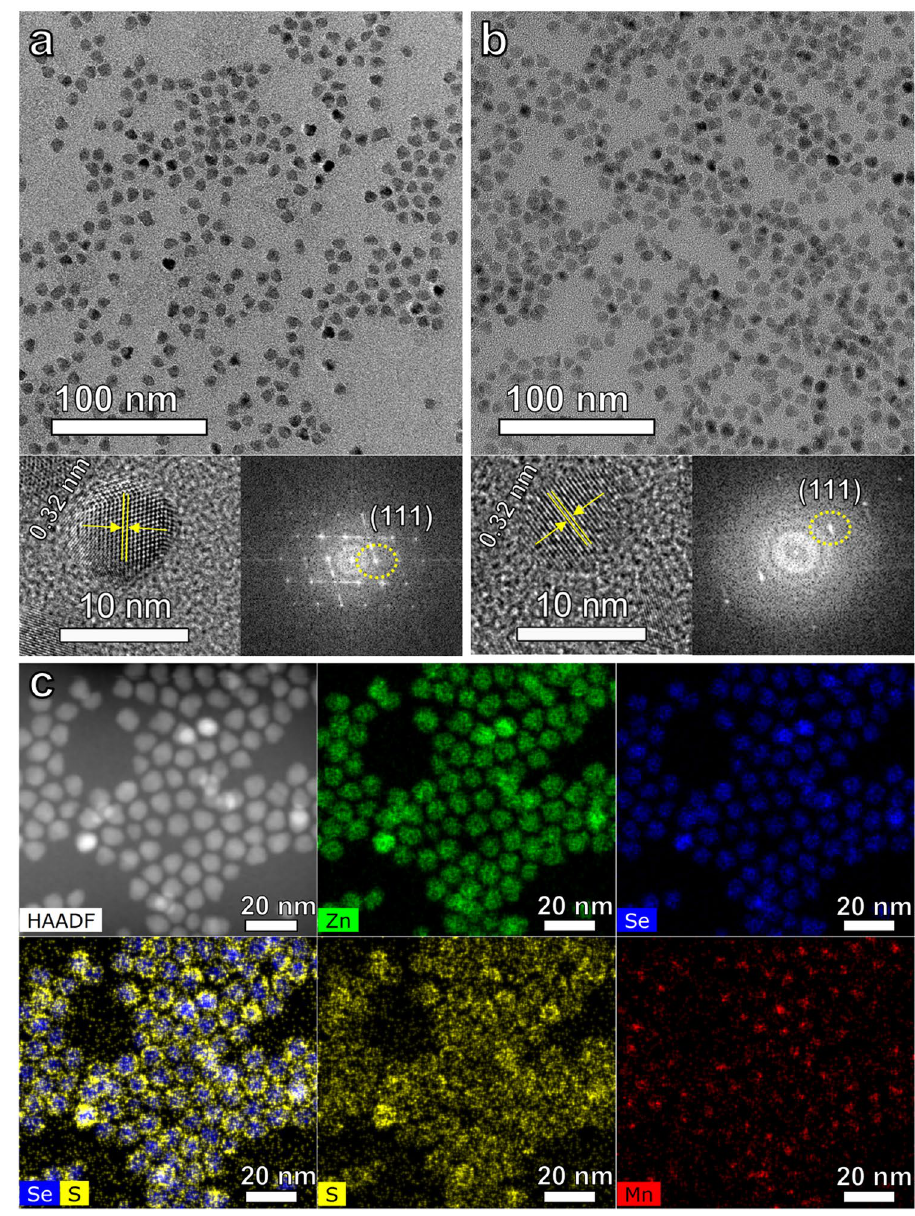
Figure 4. TEM images of ( a ) ZnSe:Mn 2+ (5%) d-C QDs and ( b ) ZnSe:Mn 2+ (5%)/ZnS d-C/S QDs. The left insets show HR-TEM images of ( a ) ZnSe:Mn 2+ (5%) d-C QDs and ( b ) ZnSe:Mn 2+ (5%)/ZnS d-C/S QDs, and the right insets show FFT patterns for the corresponding HR-TEM images. ( c ) HAADF-STEM image of the ZnSe:Mn 2+ (5%)/ZnS d-C/S QDs and EDS maps of Zn Kα (green), Se Kα (blue), S Kα (yellow), Mn Kα (red), and composite map of Se + S (blue +